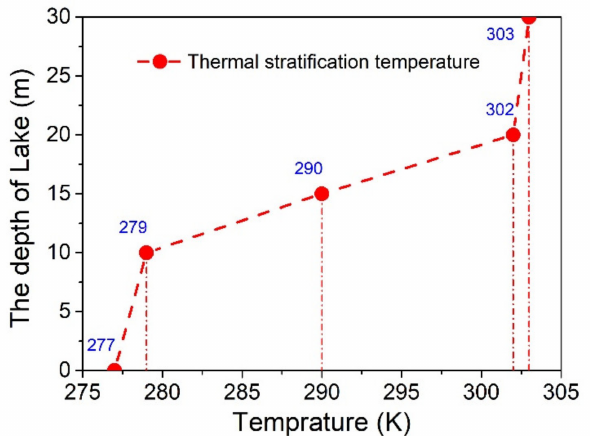
Figure 2. Temperature settings of thermal stratification of lake water